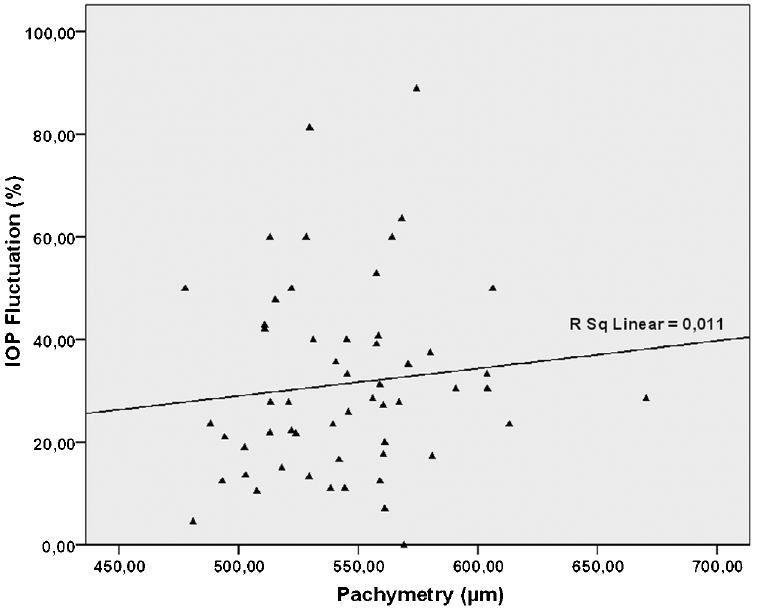
Figure 2 Correlation between Pachymetry and IOP fluctuation the Water